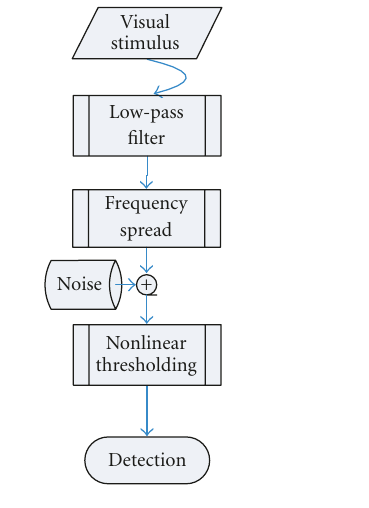
to a limited extent. The interaction between the target and the DC components should disappear when the spatial fre- quency of the stimulus is high enough. In this case, there is no e ff ect of implicit masking. Therefore, the drop of con- trast sensitivity because of implicit masking is restricted to low spatial